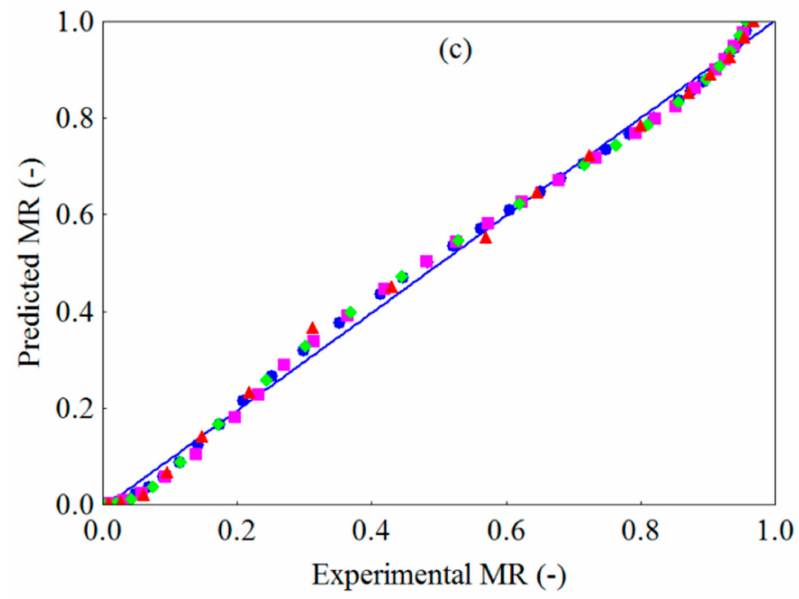
Figure 6. Dimensionless moisture content predicted by the Midilli model versus experimental dimensionless moisture content for ( a ) WR, ( b ) CR and ( c ) FR: ( ) 50 ◦ C, ( ) 60 ◦ C, ( ) 70 ◦ C, ( ) 80 ◦ C and ( ) regression line (MR Predicted = MR experimental